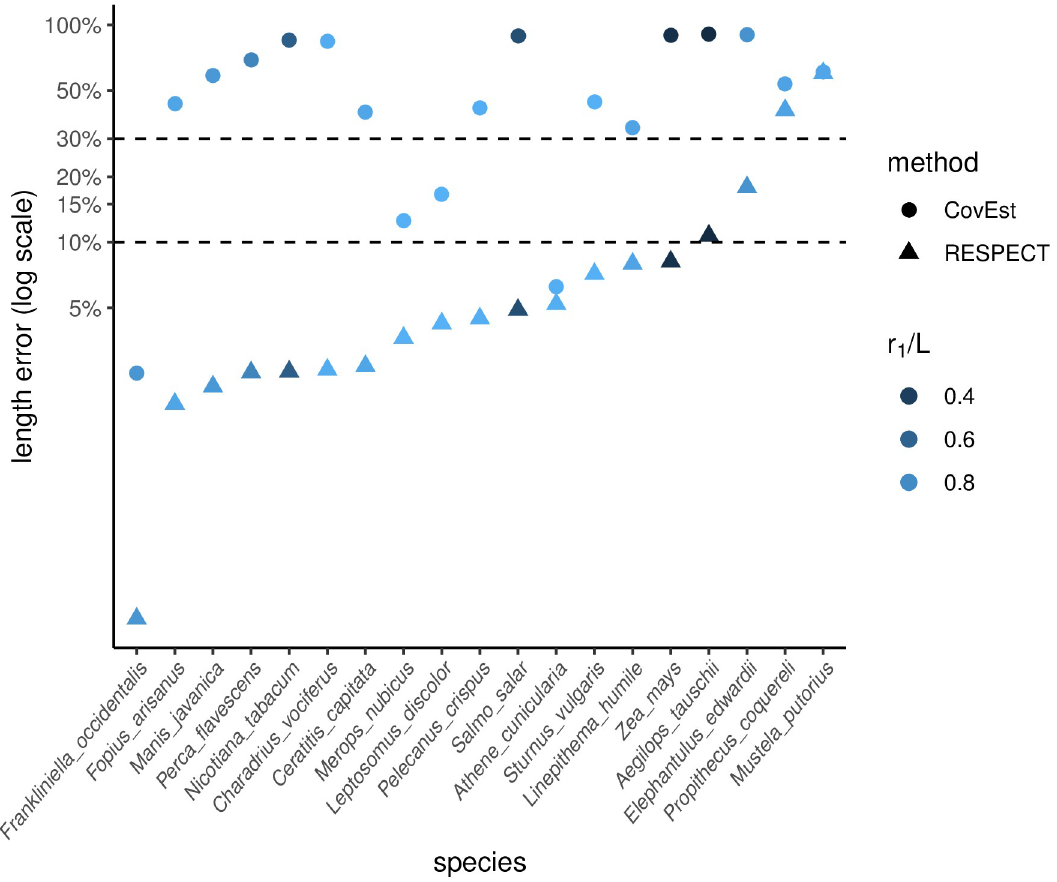
Fig 4. Estimating genome length using SRA data. Comparing the error of CovEst and RESPECT. High coverage SRA were preprocessed and later downsampled to 1X coverage. Both methods are applied to genome skims (after preprocessing) and the absolute values of the relative error in estimating the genome lengths are compared.